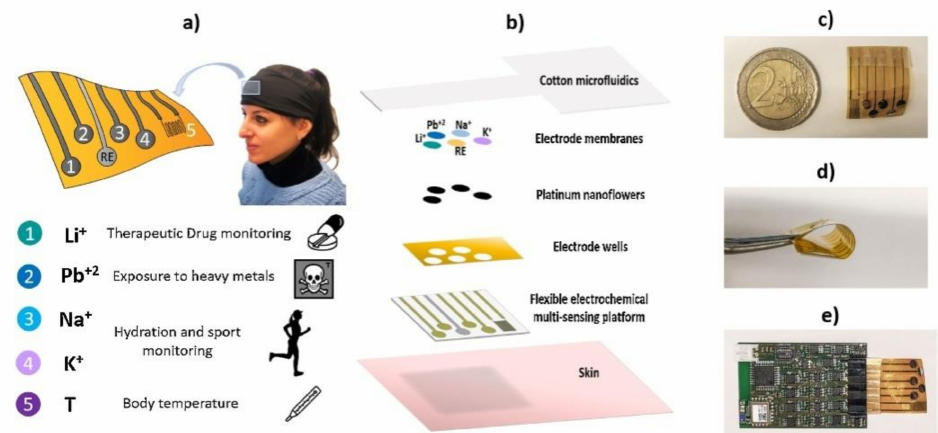
Figure 17. Overview of the sweat-monitoring wearable multi-electrode system: ( a ) medical appli- cation; ( b ) the custom made and adaptable electrochemical multi-sensing system; ( c ) the flexible electrochemical multi-electrode platform; ( d ) bending test; ( e ) example of interface with read-out electronics. (Reproduced from [405] under common creative License. Copyright 1969, Elsevier, Amsterdam, The